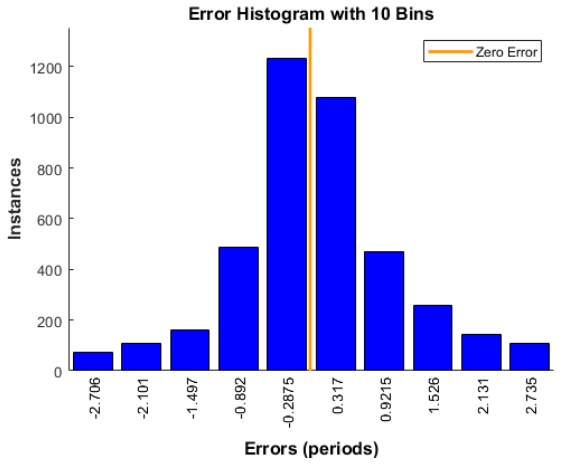
Figure 7. Error Histogram.